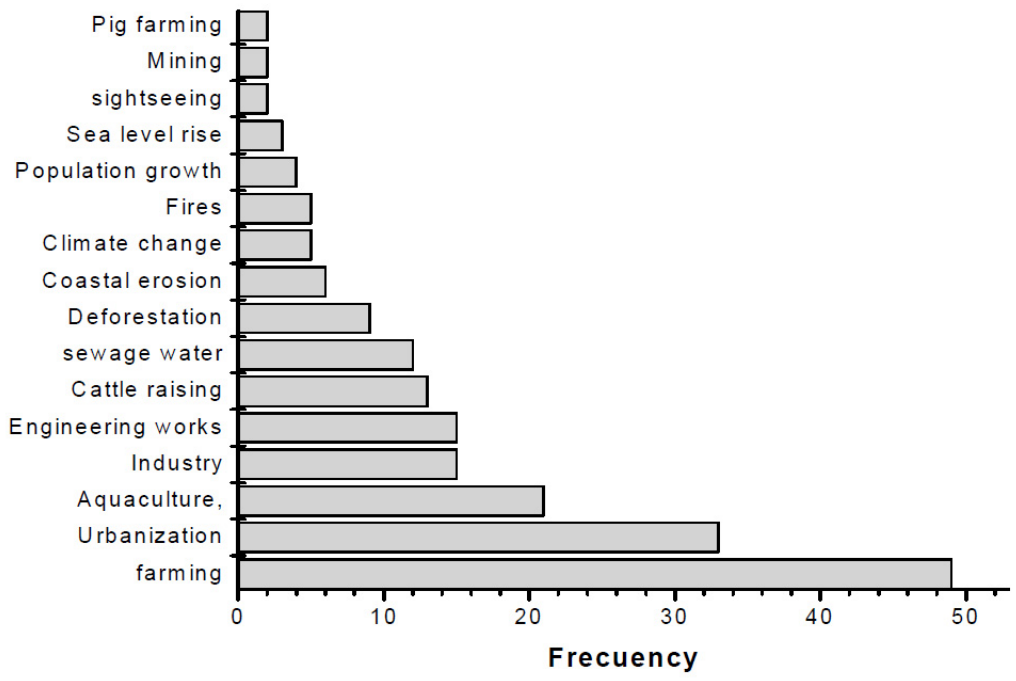
Figure 13. Frequency distribution of incident factors at a global level.